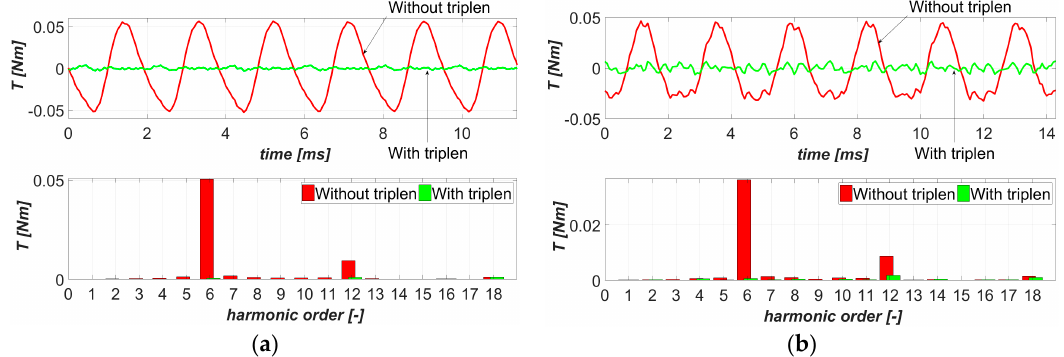
Figure 9. Comparisons of torque ripple waveforms and their harmonic contents, illustrating triplen current harmonics’ impact for ( a ) machine no. 1 with n s / n p equal to 9/10, and ( b ) machine no. 2 with n s / n p equal to 9/8.